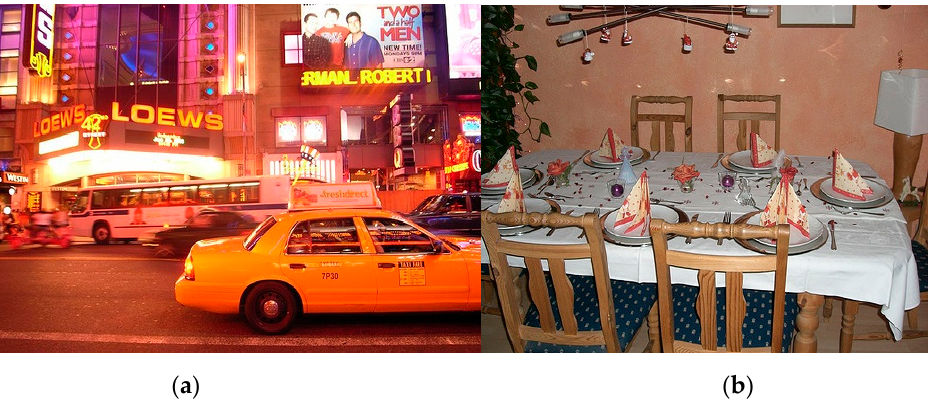
Figure 4. Some detection results of our model. ( a ) is a picture of road scene, ( b ) is a picture of dining room.